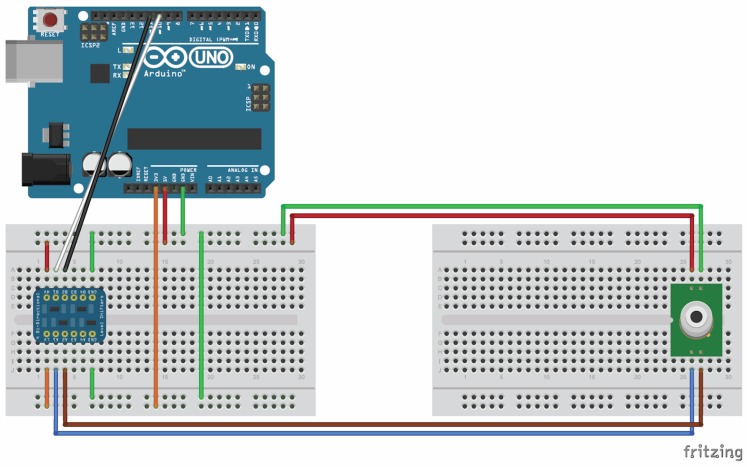
Outline of the wiring diagram.A Fritzing (fritzing.org) sketch is presented outlining the wiring connections between the microcontroller, the logic converter, and the oxygen sensor.